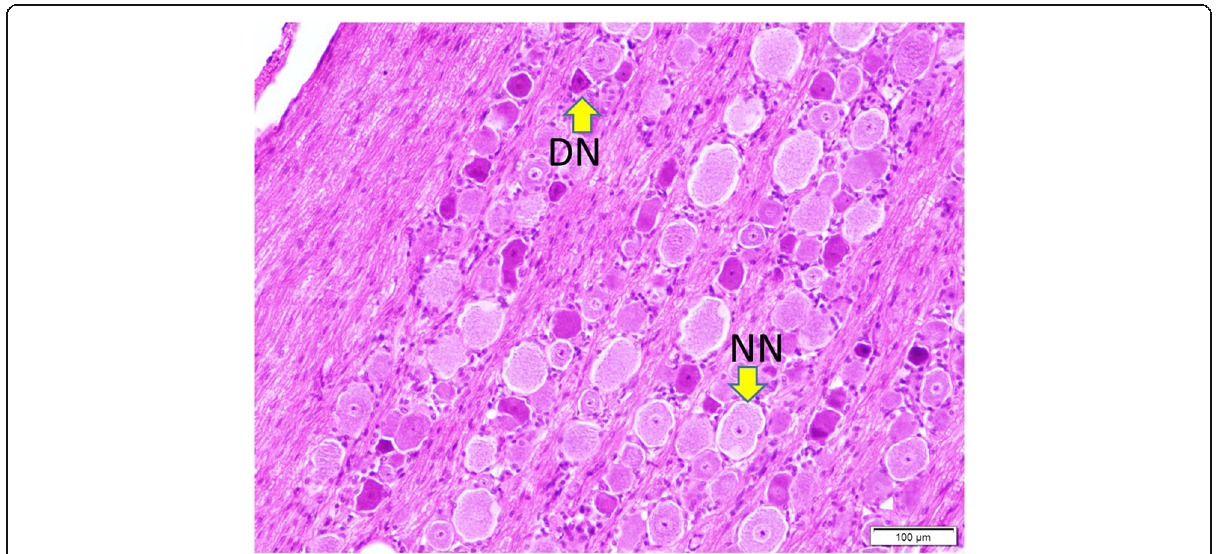
Fig. 7 Histopathological appearance of normal (NN) and degenerated (DN) neurons, including DRG, in an animal that underwent thermocautery (LM, H&E, ×